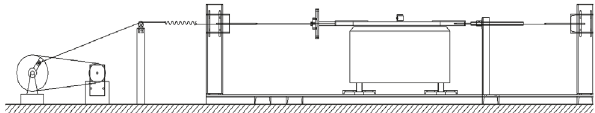
Figure 3: Design drawing of experimental installations.